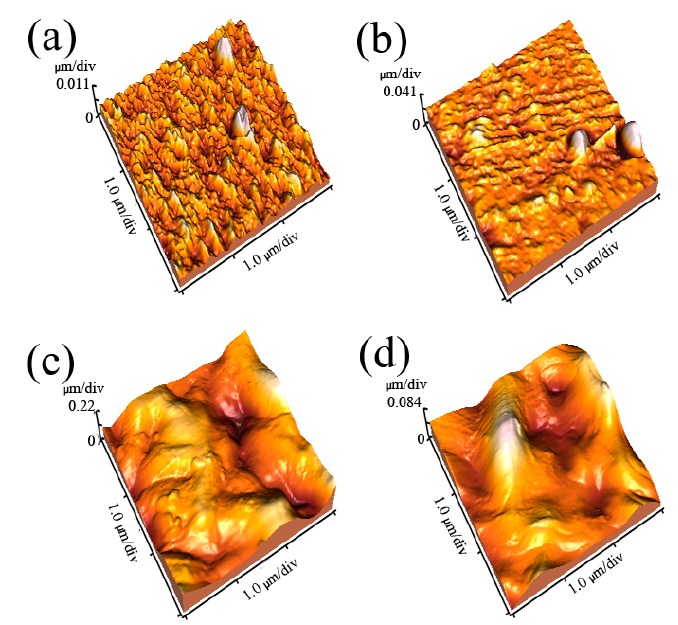
Figure 3. Atomic force microscopy (AFM) images of the reference membrane surface ( a ), S1 ( b ), S2 ( c ), and S3 ( d ).